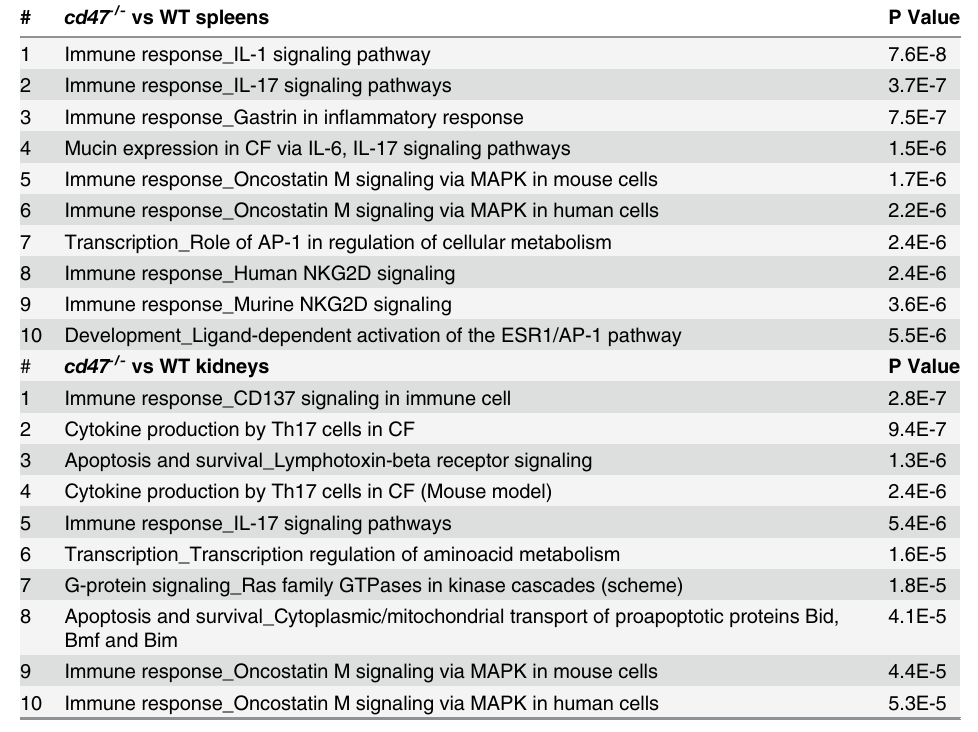
Table 3. Analysis of GeneGo pathway maps.